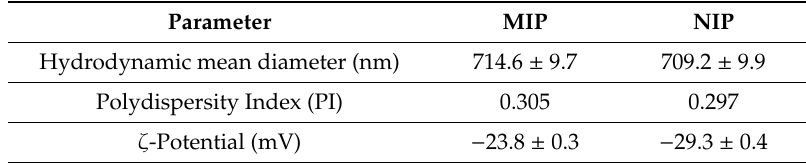
Table 1. Hydrodynamic mean diameter, Polydispersity Index (PI), and ζ -Potential for MIP and NIP particles.